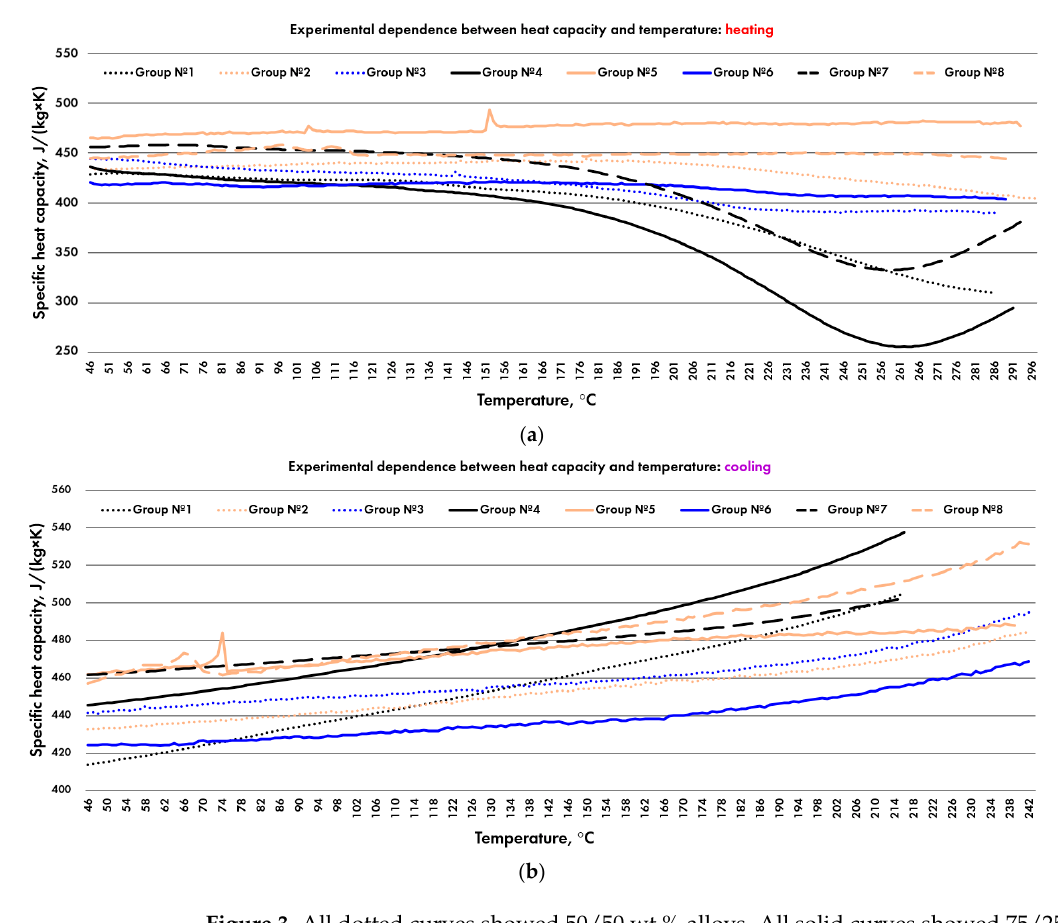
Figure 3. All dotted curves showed 50/50 wt.% alloys. All solid curves showed 75/25 wt.% alloys. All dashed curves showed alternating-layers gradient alloys. Bright black curves showed C61800- based alloys. Pale orange curves showed C18400-based alloys. Blue curves of medium brightness showed CB480K-based alloys. Measurement precision was ± 2.5%. ( a ) Experimental dependence between specific heat capacity and temperature while heating; ( b ) Experimental dependence between specific heat capacity and temperature while cooling.